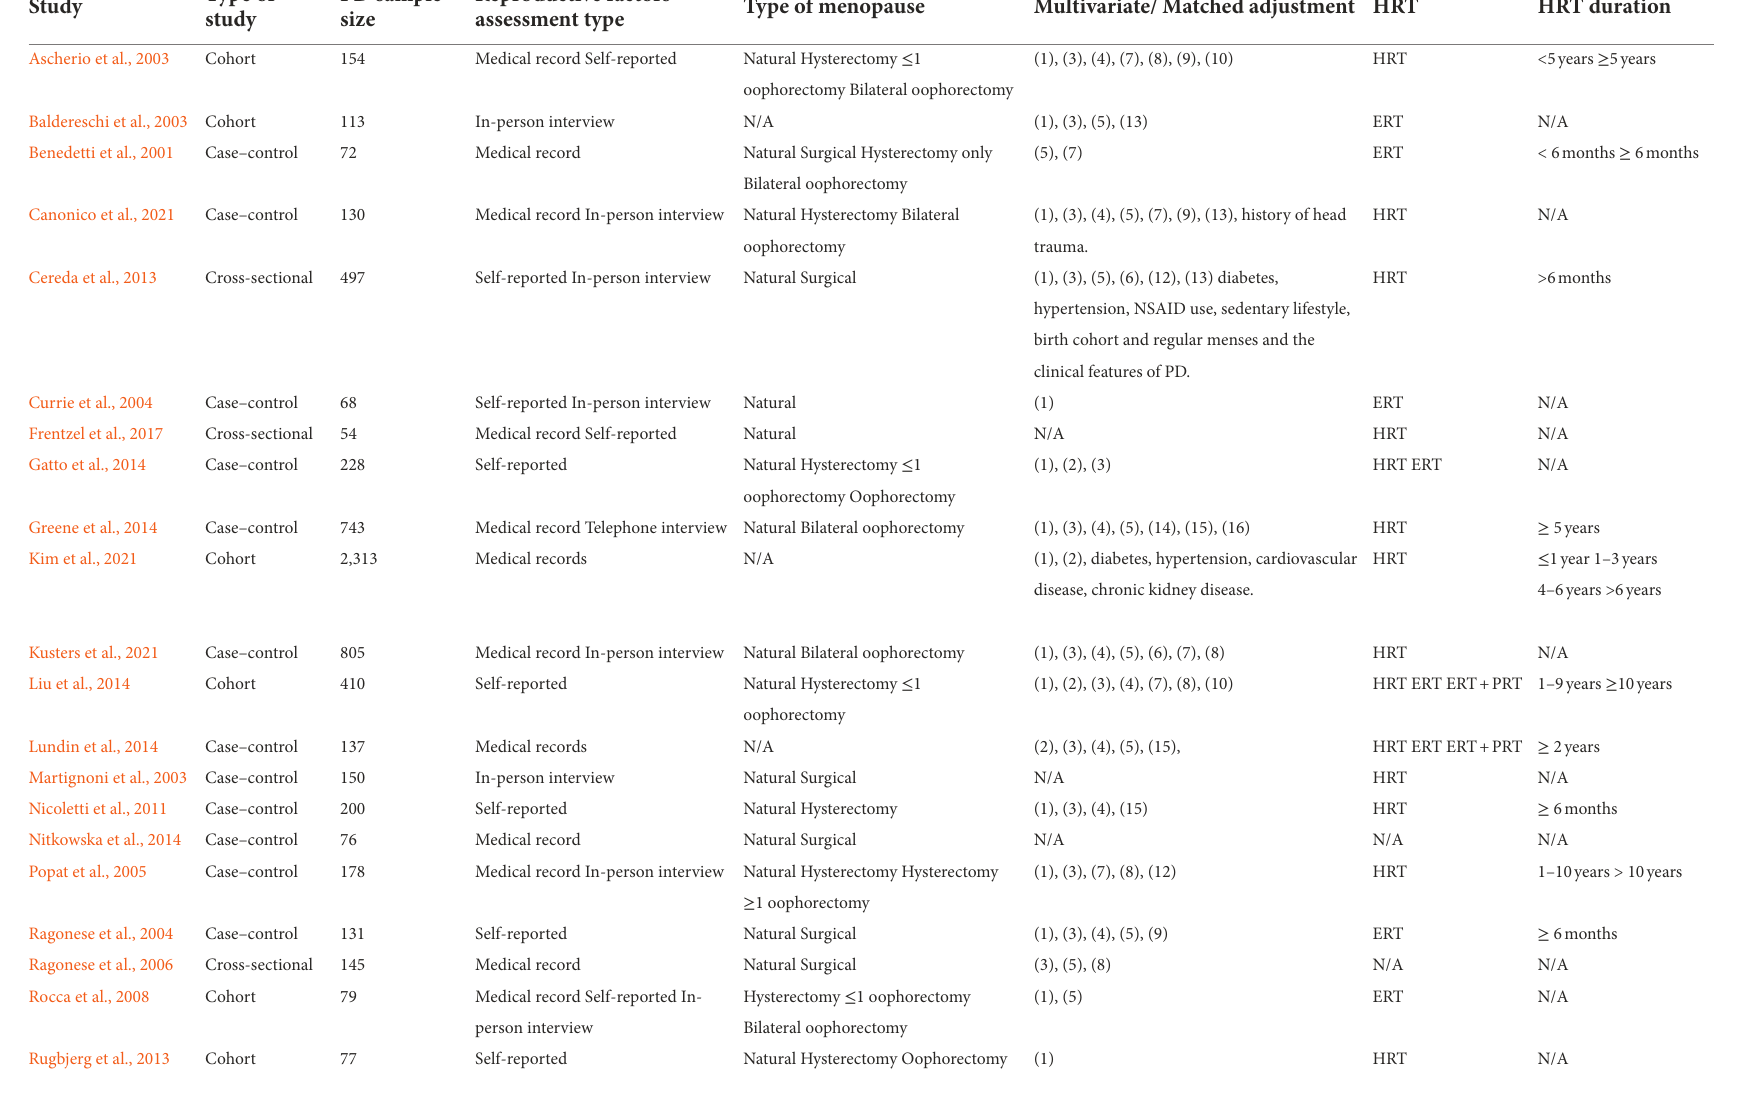
TABLE 1 Observational studies on menopause and HRT and the association with risk of PD included in the main